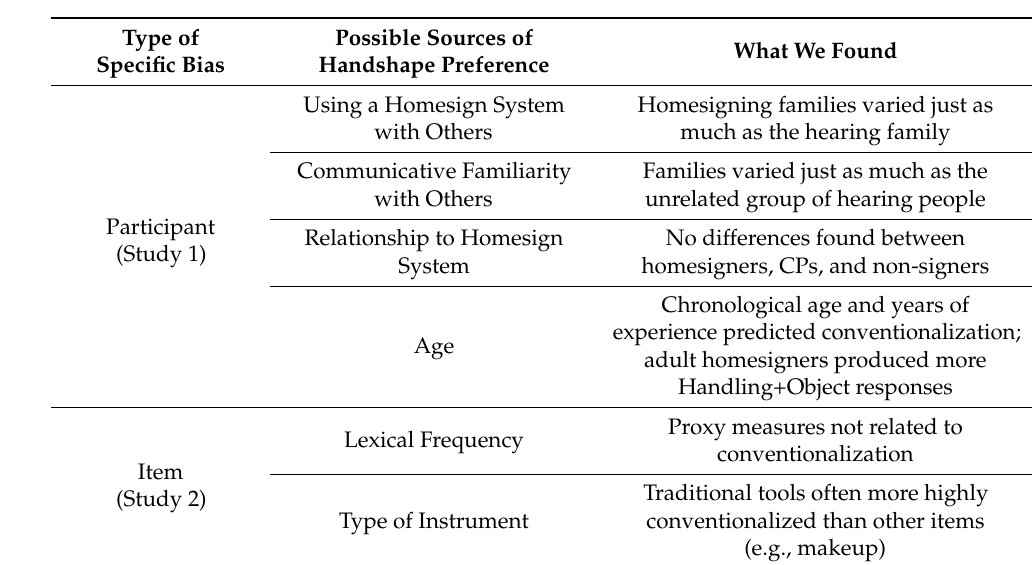
Table 7. Results